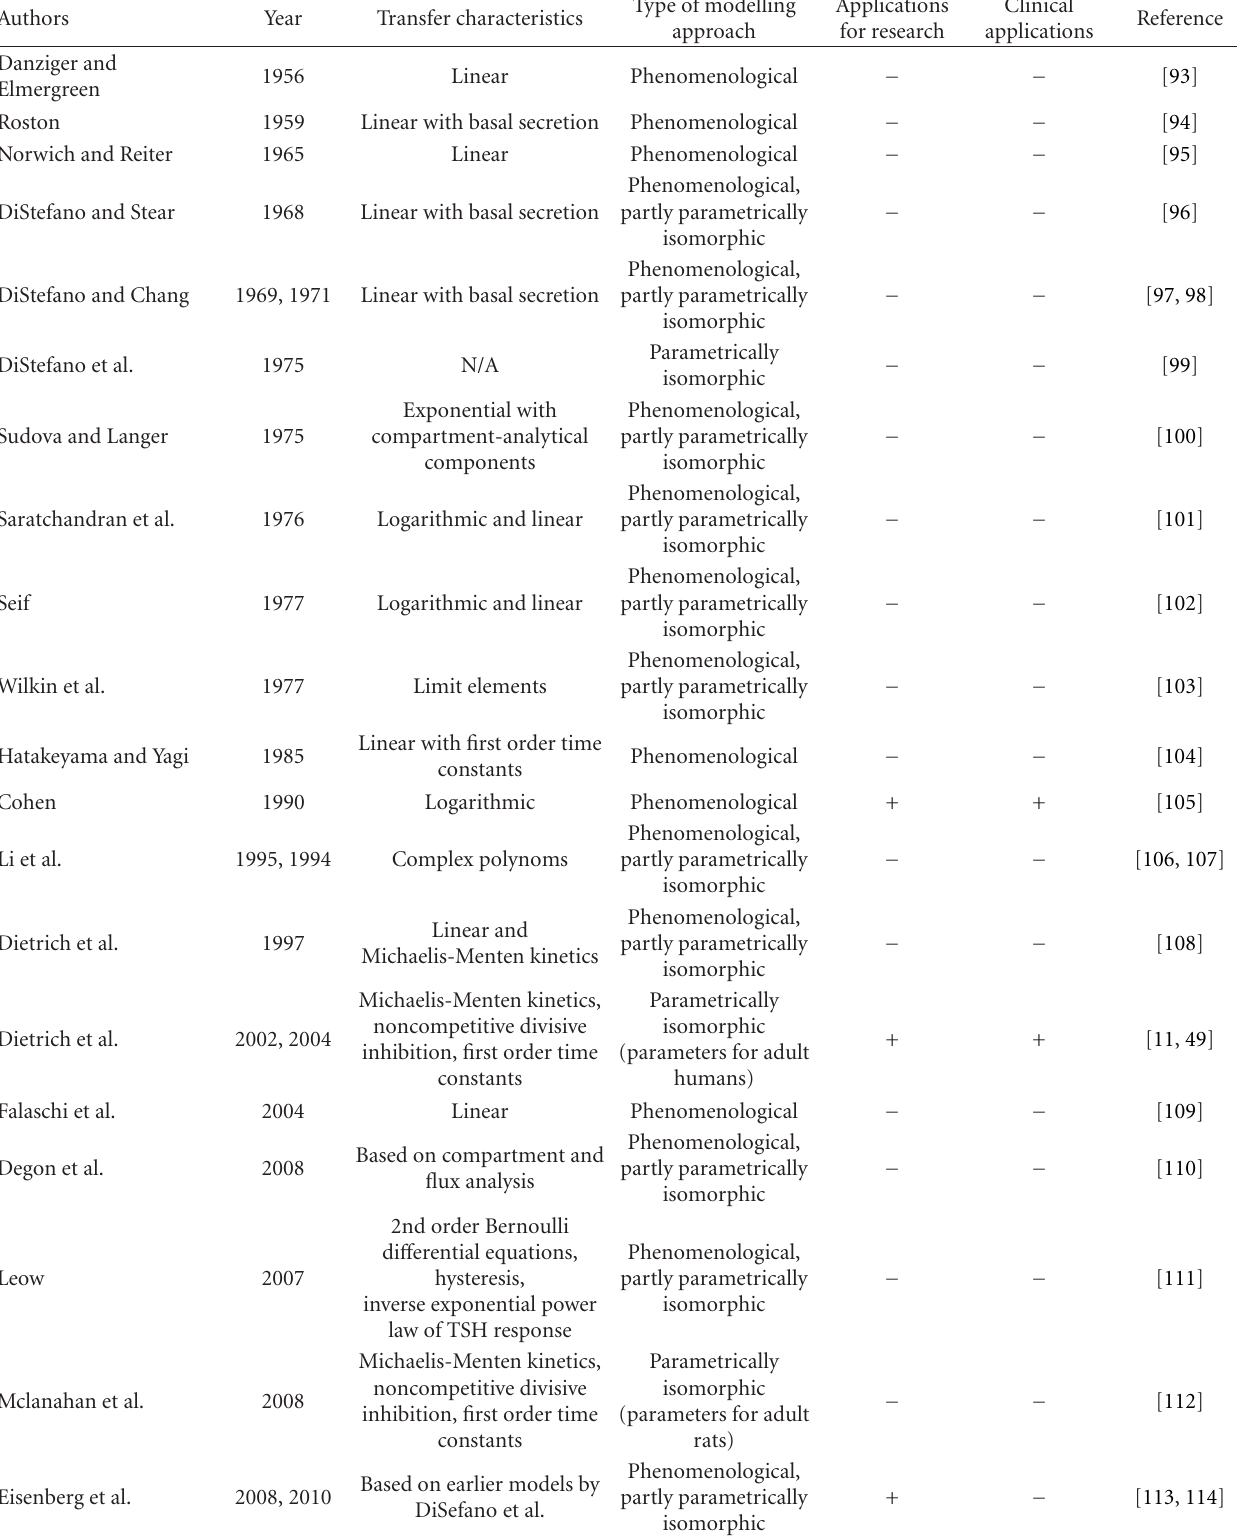
Table 1: Overview of published models of thyrotropic feedback control. Applications for research refer to any scientific exploitation outside of the modelling context itself, for example, for reasoning in clinical trials or generation of